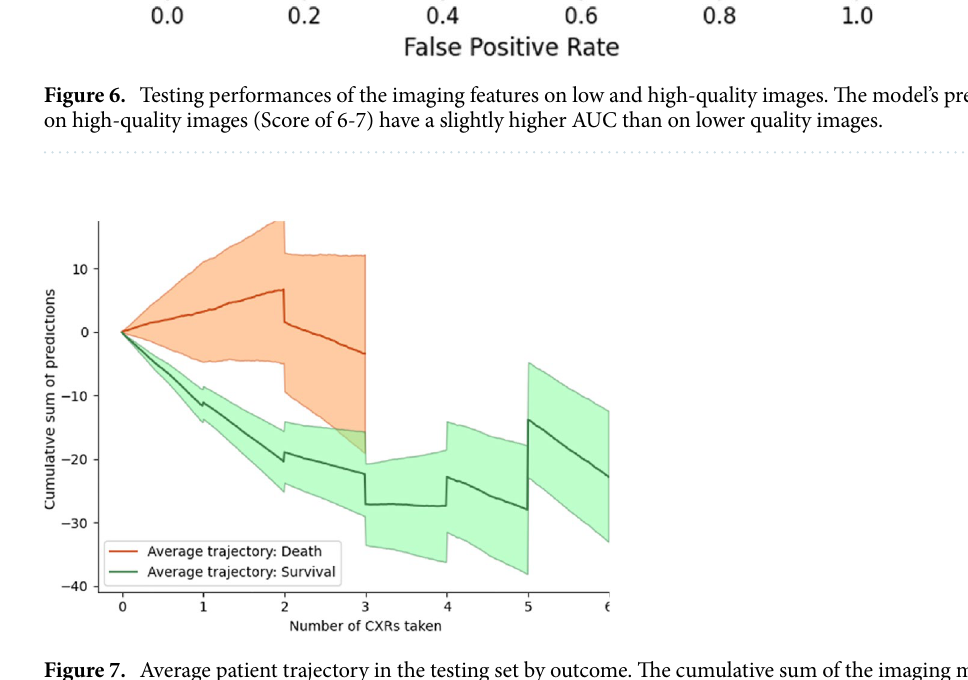
Figure 7. Average patient trajectory in the testing set by outcome. The cumulative sum of the imaging model predictions over repeated CXRs enabled the tracking over time, post-intubation, of the potential recovery of patients. The shaded area represents a standard deviation, with discontinuities in the curve when the number of patients change. The curves are stopped when only three patients are left in each outcome